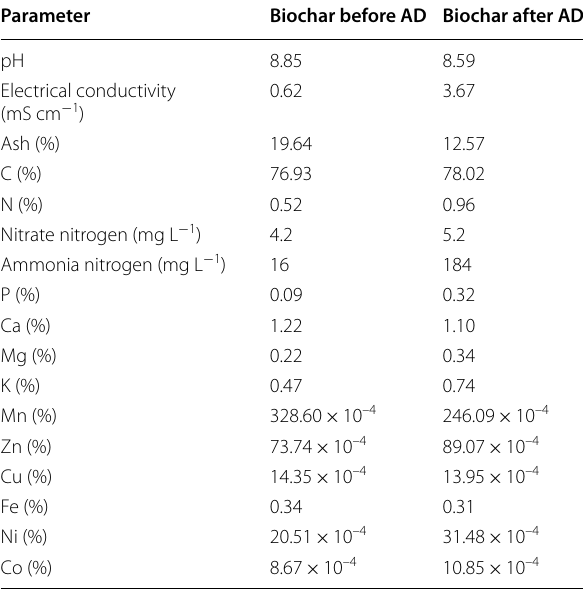
Data given on dry matter basis